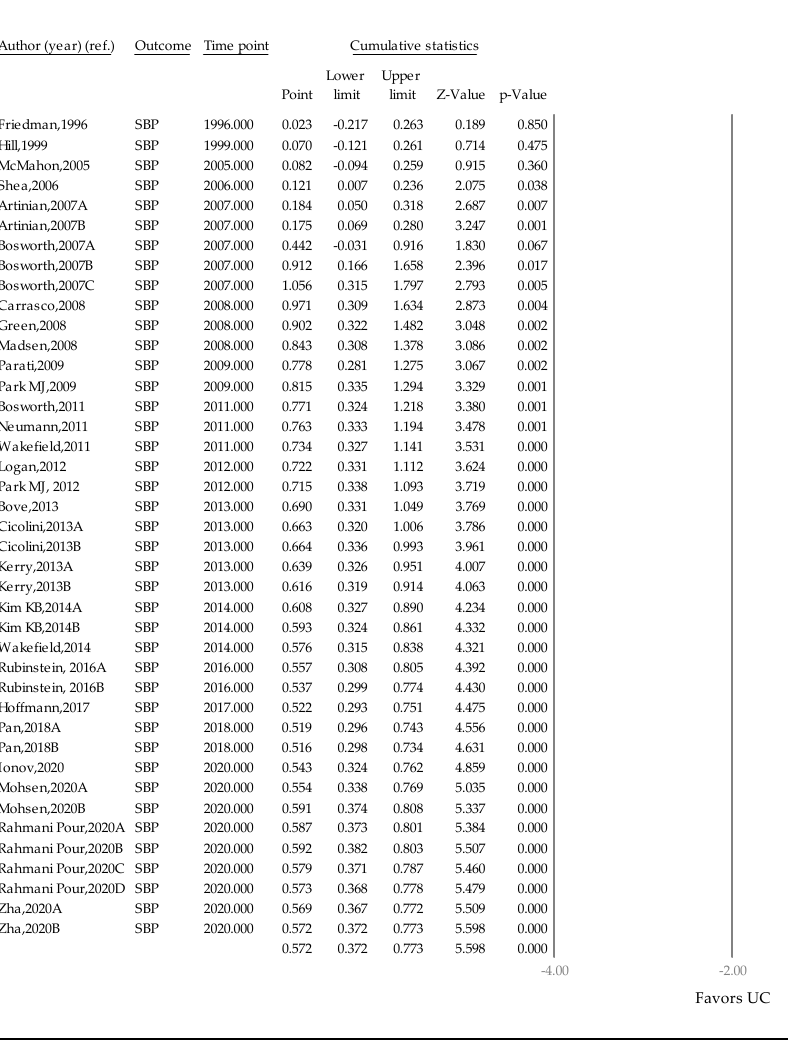
Figure 3. A funnel plot of standardized mean difference in diastolic blood pressure. Note: summary effect size ( ◇ ), sum- mary effect size of imputed studies ( ◆ ), individual study ( ○ ).